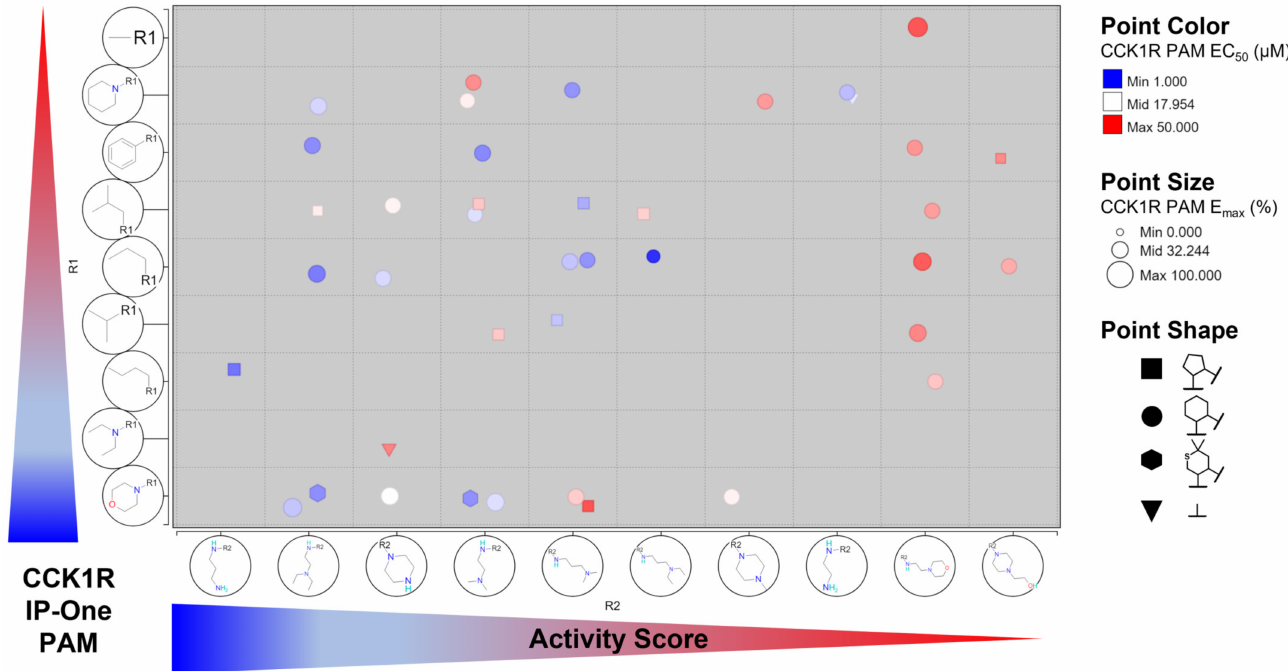
Figure 7. R-group analysis of 40 tetracyclic analogs with basic amino functions. Compounds identified by R1, R2, and point shape (ring A); point color indicates CCK1R PAM EC 50 ( µ M), point size indicates CCK1R PAM E max (%); R1 and R2 groups ranked via median activity score with higher scores at bottom left corner. R-group analysis was generated via the Certara D360 scientific informatics